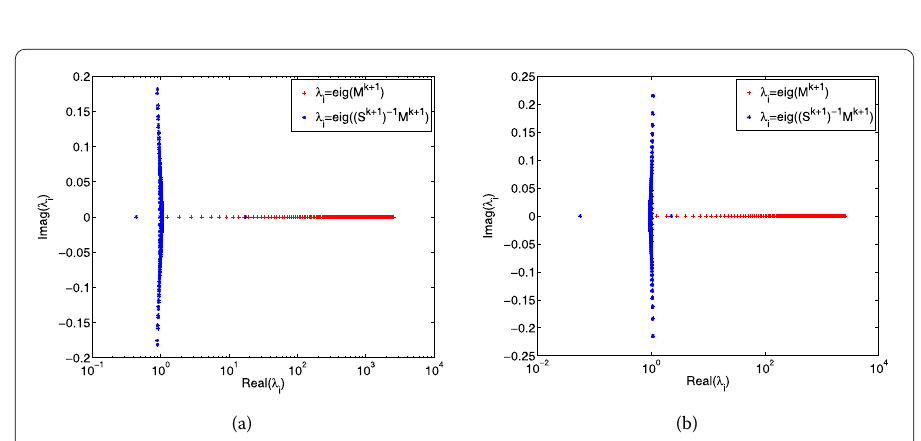
Figure 3 Spectrum of original matrix (red) and preconditioned matrix (blue) for Example 5.1 at time level ( a ): k = 0 and ( b ): k = 1, respectively, when M = N = 256, α = 0.5, q = 10, β = 1.8, and T =